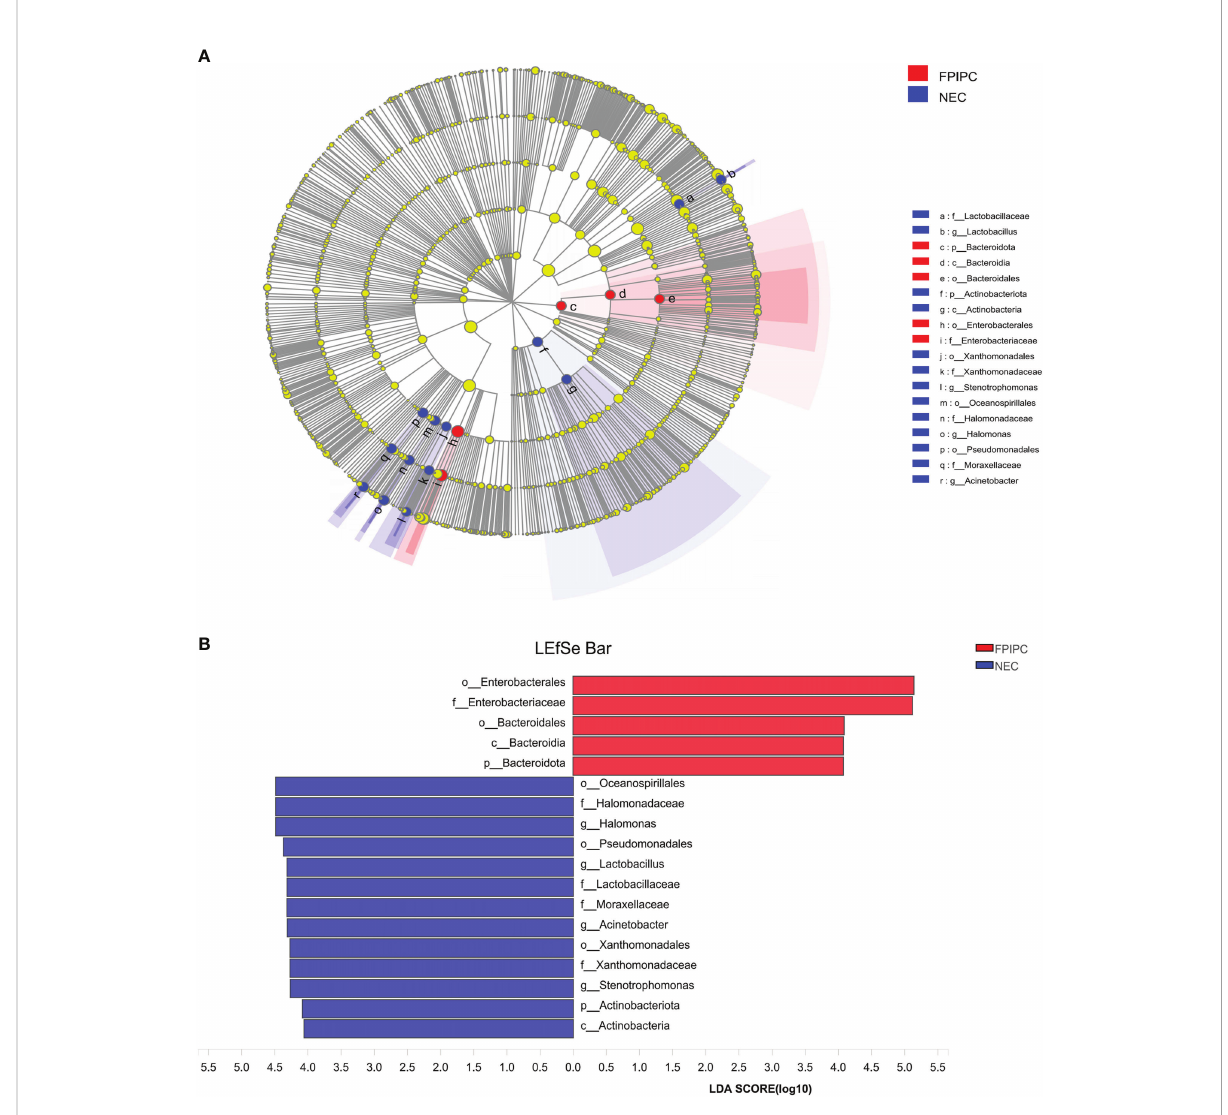
FIGURE 6 Differentially abundant taxa between the necrotizing enterocolitis (NEC) and food protein-induced allergic protocolitis (FPIAP) groups analyzed by Linear discriminant analysis (LDA) effect size (LEfSe) were shown in cladogram and histogram. (A) Comparative analysis of the gut microbiota by LEfSe: the cladogram shows bacterial taxa signi fi cantly higher in the group of infants of the same color, in the gut microbiota between NEC and FPIAP infants; (B) Gut microbiota analysis via LDA score between NEC and FPIAP infants. N =22 for NEC and N =21 for